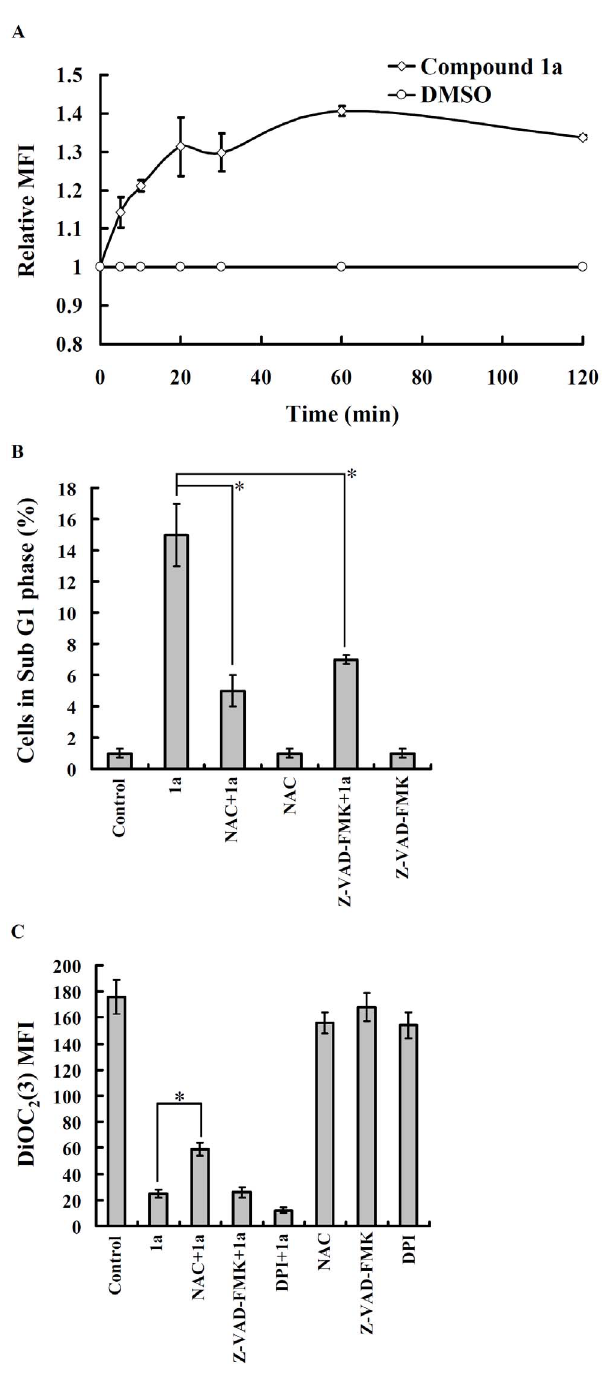
Figure 4. Compound 1a-induced apoptosis is dependent on oxidative stress. ( A ) OEC-M1 cells were incubated with 2 9 ,7 9 - dichlorofluorescein diacetate (2 m M) for 30 min, followed by compound 1a (5 m M) or vehicle (0.1% DMSO) treatment for the time indicated. The relative mean fluorescence intensity (MFI) of 2 9 ,7 9 -dichlorofluorescein was detected at an excitation wavelength of 485 nm and an emission wavelength of 530 nm with a fluorometer; n=3. ( B ) OEC-M1 cells were incubated with N -acetyl-cysteine (NAC) (10 mM) or Z-VAD-FMK (50 m M) for 30 min, followed by compound 1a (5 m M) or vehicle treatment for 24 h. The cell cycle distribution was determined by flow cytometry after PI-staining of nuclei. The data were expressed as mean 6 SD; n=3. ( C ) OEC-M1 cells were incubated with NAC (10 mM), Z-VAD-FMK (50 m M), or DPI (25 m M) for 30 min, followed by compound 1a (5 m M) or